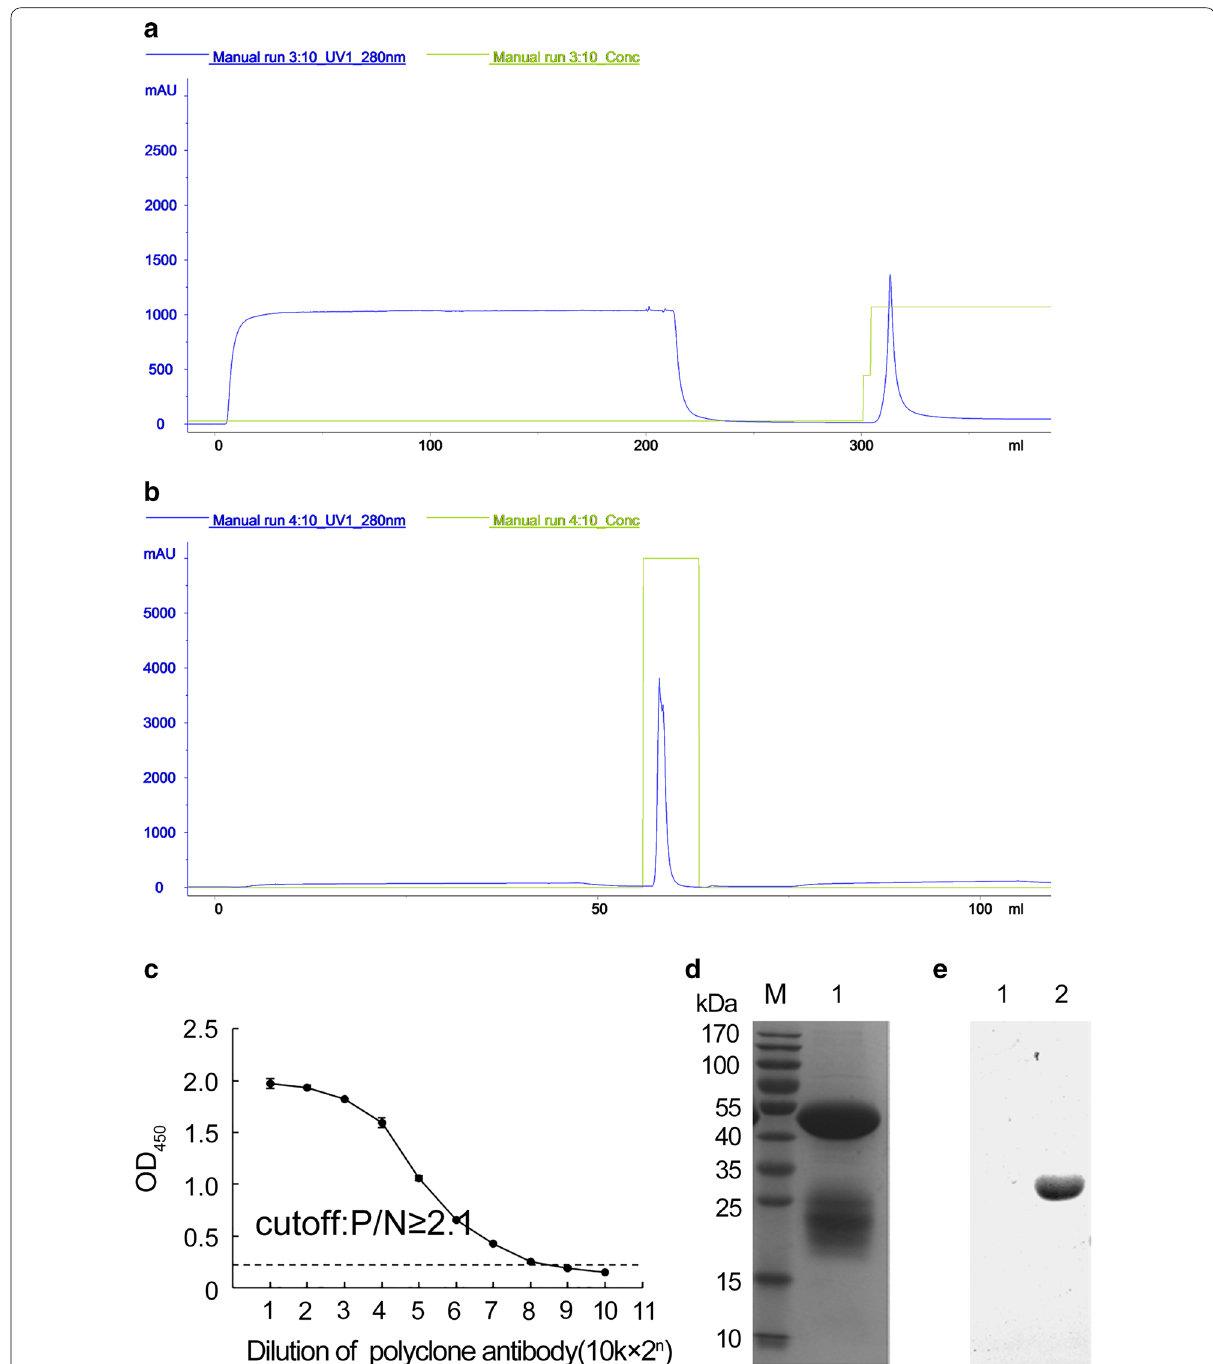
Fig. 3 Preparation of polyclonal antibody against peptide-BSA conjugate. a Immunoaffinity chromatography purification of the polyclonal antibody. b Protein A chromatography purification of the polyclonal antibodies. c Titer detection of the polyclonal antibody. d Purity detection of the polyclonal antibody. Lane M protein molecular weight markers; lane 1 purified polyclonal antibody. e Reactivity of polyclonal antibody against peptide-BSA conjugate. Lane 1 dTMP-GH; lane 2